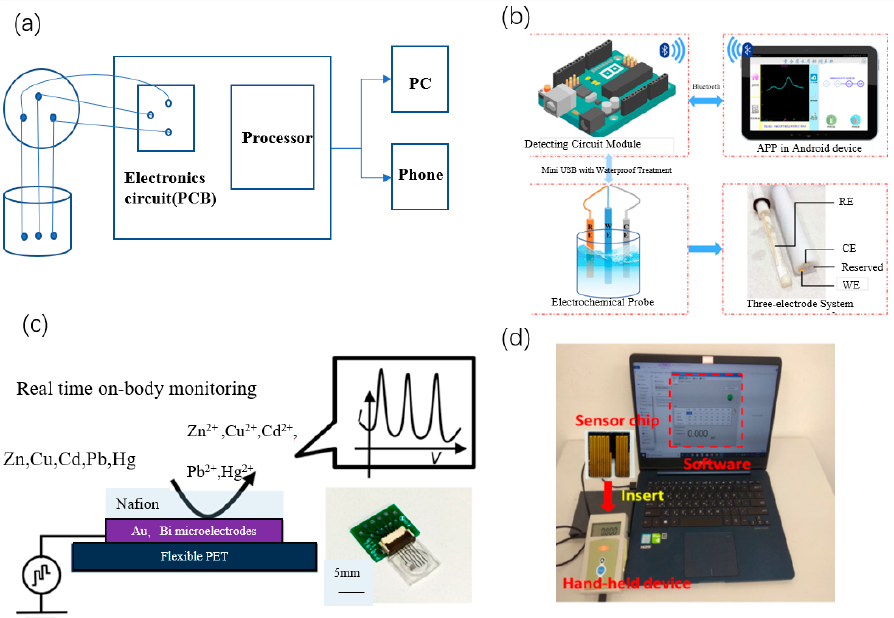
Figure 5. ( a ) Electrochemical sensor for Cd 2+ and Cu 2+ detection in soil [74], ( b ) Cu 2+ portable elec- trochemical sensing system [75], ( c ) image of microsensor array with a system detection process [76], and ( d ) handheld measurement setup based on impedance changes [77].